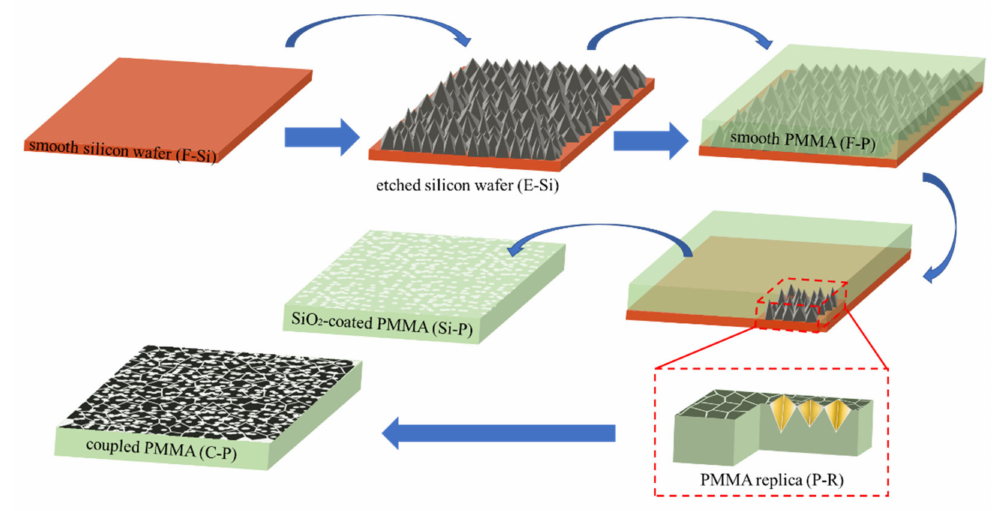
Figure 2. The schematic drawing of the sample preparation